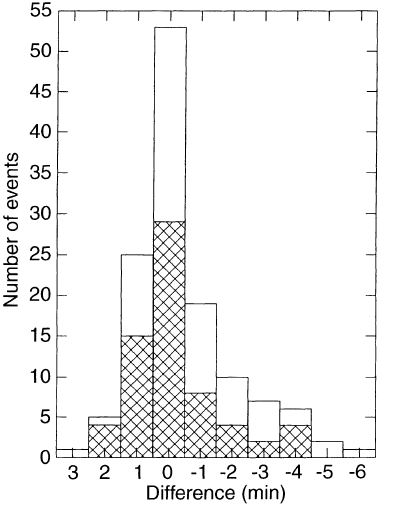
Fig. 8. Histogram showing the di(cid:128)erences in onset times of Pi2 signatures determined visually and by the ANN; the signs are in the sense of visual minus ANN timing. The cross hatched and plain regions represent the di(cid:128)erences for data sets 1 and 2,